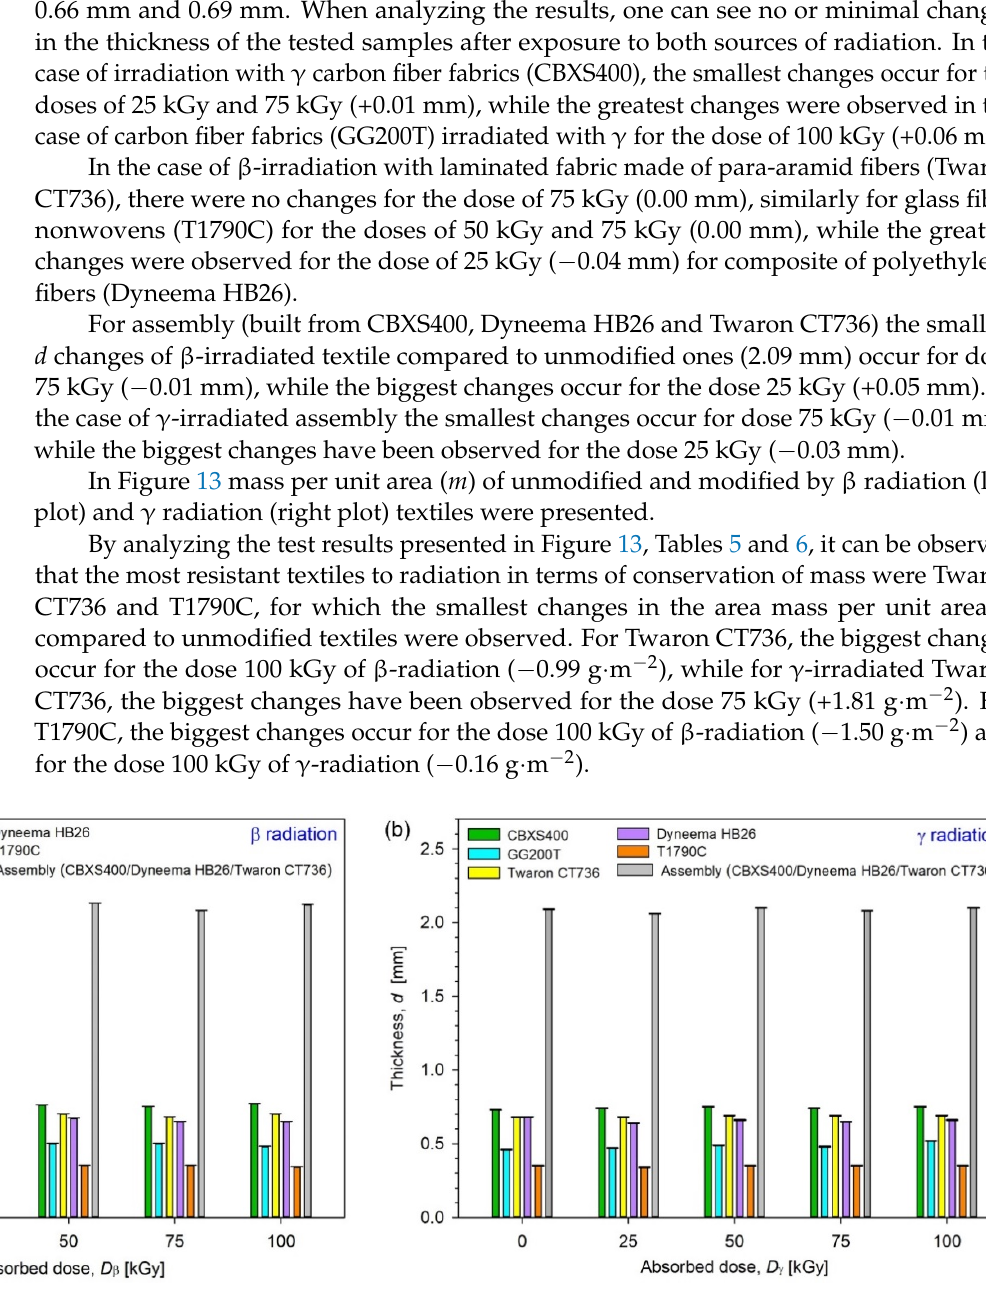
Figure 12. Thickness of unmodified and irradiated textiles using ( a ) β-radiation, ( b ) γ-radiation. For assembly (built from CBXS400, Dyneema HB26 and Twaron CT736) the small- est d changes of β-irradiated textile compared to unmodified ones (2.09 mm) occur for dose 75 kGy (−0.01 mm), while the biggest changes occur for the dose 25 kGy (+0.05 mm). In the case of γ-irradiated assembly the smallest changes occur for dose 75 kGy (−0.01 mm), while the biggest changes have been observed for the dose 25 kGy (−0.03 mm). In Figure 13 mass per unit area ( m ) of unmodified and modified by β radiation (left plot) and γ radiation (right plot) textiles were presented. Figure 13. Mass per unit area of unmodified and irradiated textiles using ( a ) β-radiation, ( b ) γ- radiation. By analyzing the test results presented in Figure 13, Tables 5 and 6, it can be ob- served that the most resistant textiles to radiation in terms of conservation of mass were Twaron CT736 and T1790C, for which the smallest changes in the area mass per unit ar- ea m compared to unmodified textiles were observed. For Twaron CT736, the biggest changes occur for the dose 100 kGy of β-radiation (−0.99 g·m −2 ), while for γ-irradiated Twaron CT736, the biggest changes have been observed for the dose 75 kGy (+1.81 g·m −2 ). For T1790C, the biggest changes occur for the dose 100 kGy of β-radiation (−1.50 g·m −2 ) and for the dose 100 kGy of γ-radiation (−0.16 g·m −2 ). For assembly (built from CBXS400, Dyneema HB26 and Twaron CT736), the small- est m changes of β-irradiated textile compared to unmodified ones (1129.44 g·m −2 ) occur for dose 75 kGy (−0.30 g·m −2 ), while the biggest changes occur for the dose 100 kGy (−5.34 g·m −2 ). In the case of γ-irradiated assembly, the smallest changes occur for dose 75